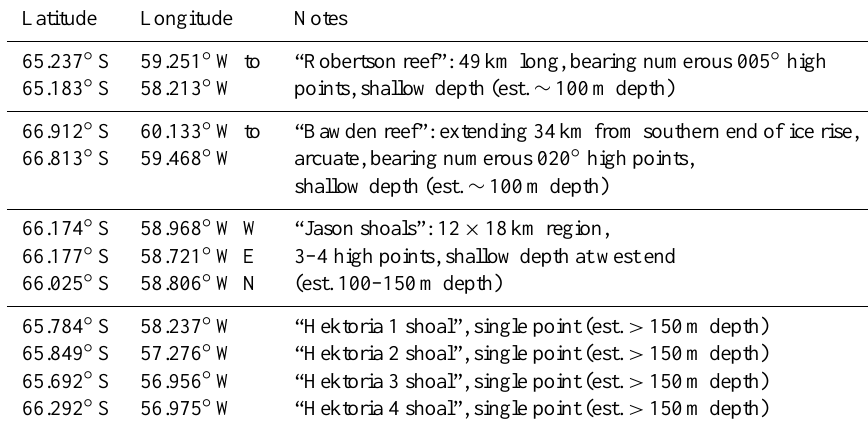
Table 1. Reef and shoal areas in the northwestern Weddell Sea ∗ . Latitude